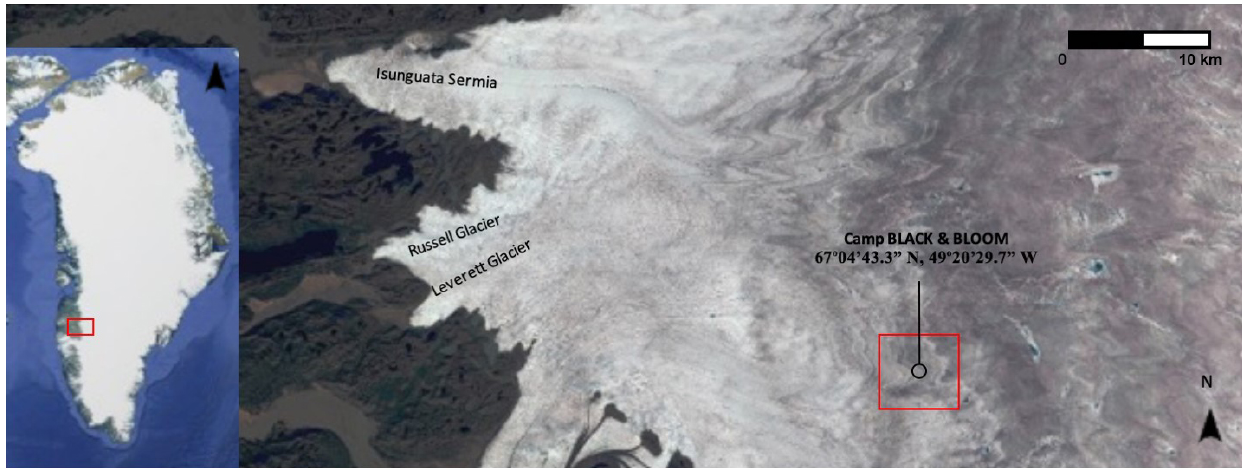
Figure 1. Map showing location of Camp Black & Bloom 2016 (67 ◦ 04 (cid:48) 43.3 (cid:48)(cid:48) N, 49 ◦ 20 (cid:48) 29.7 (cid:48)(cid:48) W). Background image sourced from Sentinel 2, taken on 26 July 2016. The left panel was created with